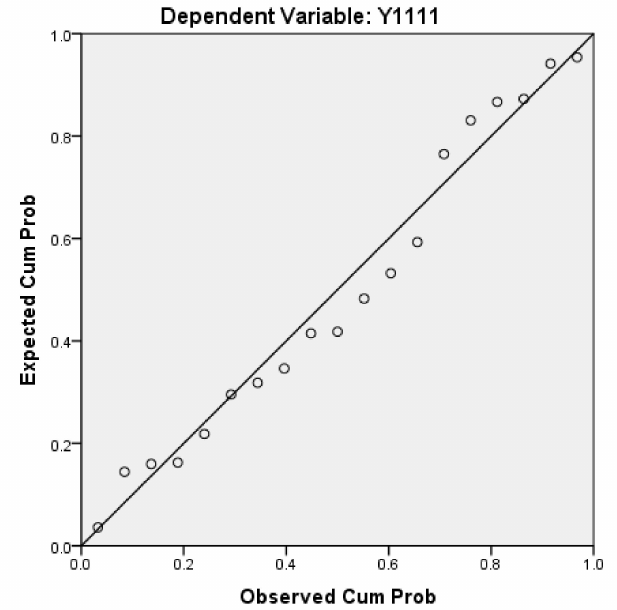
Figure 10. Normal P–P plot regression standardized